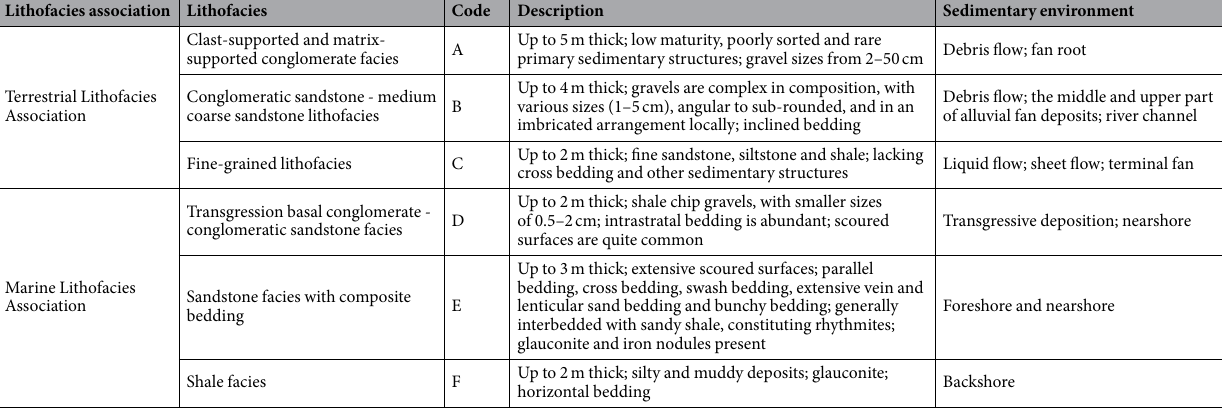
Table 1. Characteristics of the lithofacies association identified in the Bingmagou